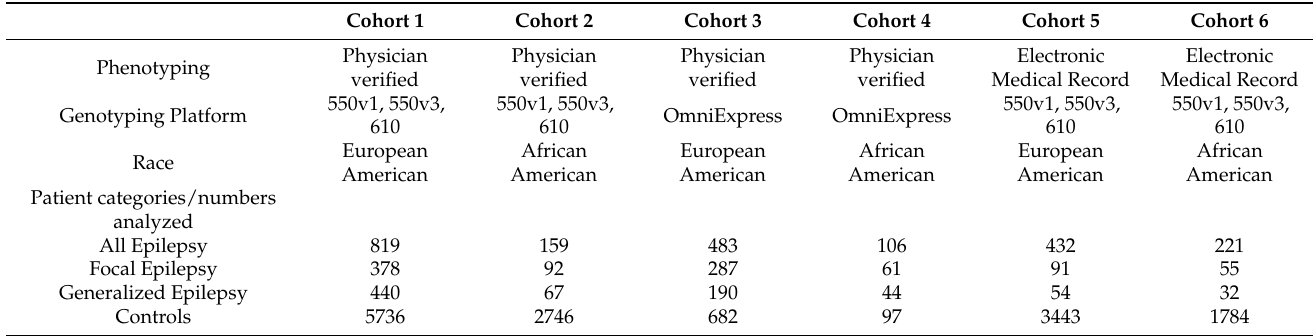
Table 1. Epilepsy